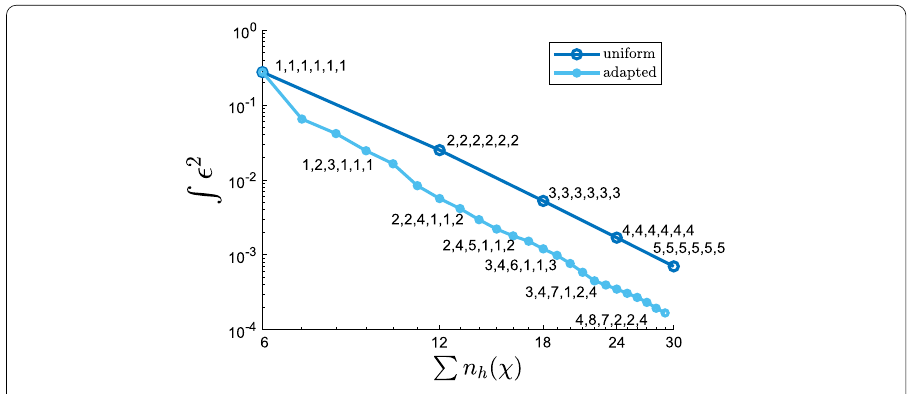
Fig. 11 Comparison between the uniform mesh refinement and the adaptivity method for the integral of the energy of the error as a function of the element partitions. The detail numbers are the number of elements in each parameter, respectively k 1 , k 2 , β 1 , γ 1 , b 1 , b